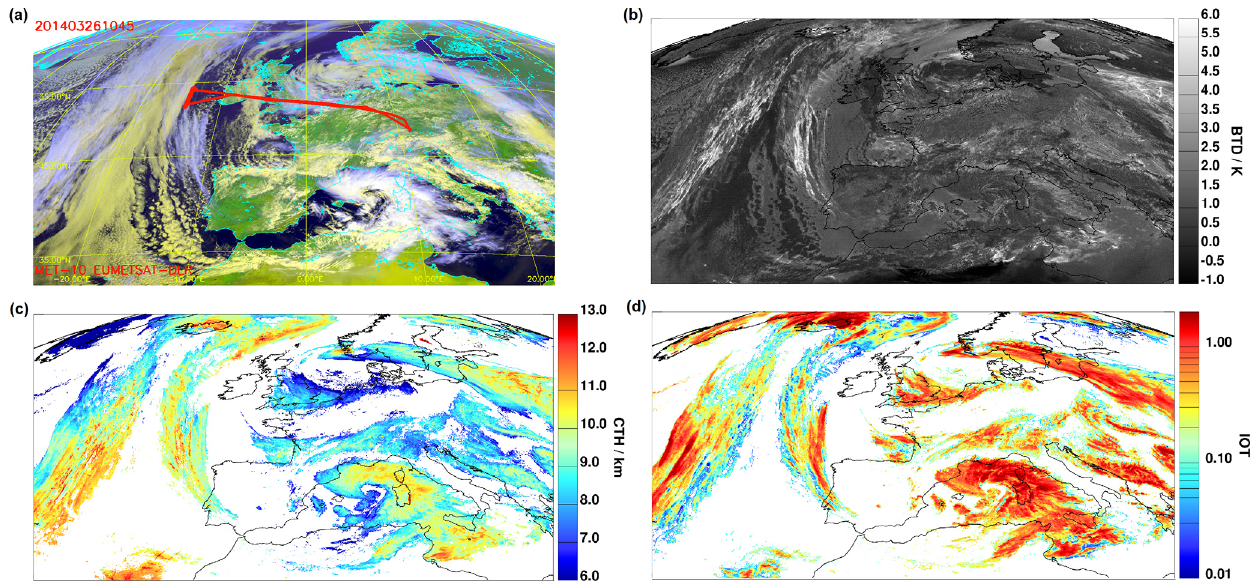
Figure 1. (a) The false color RGB image from MSG/SEVIRI overlapped with the HALO flight track on 26 March 2014 at 10:45UTC showing Europe and the eastern part of the North Atlantic Ocean, (b) corresponding 10.8µm and 12.0µm brightness temperature differ- ences (BTDs) (K) with overlaid ice clouds, (c) CTH and (d) IOT from CiPS.